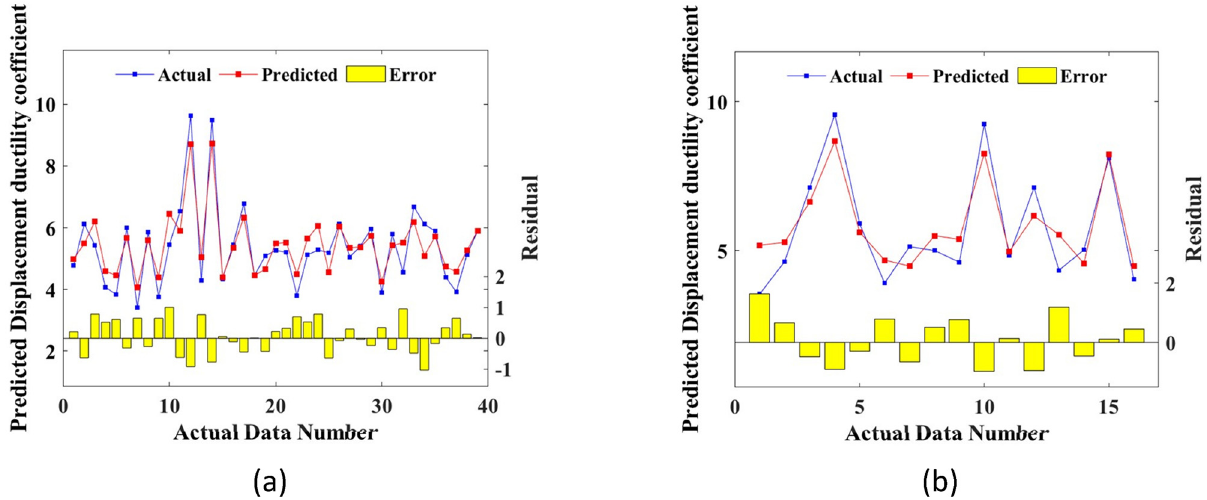
Figure 16: Scatter plot of simulated and actual displacement ductility coe ffi cient for training and test sets. ( a ) Training dataset. ( b ) Testing